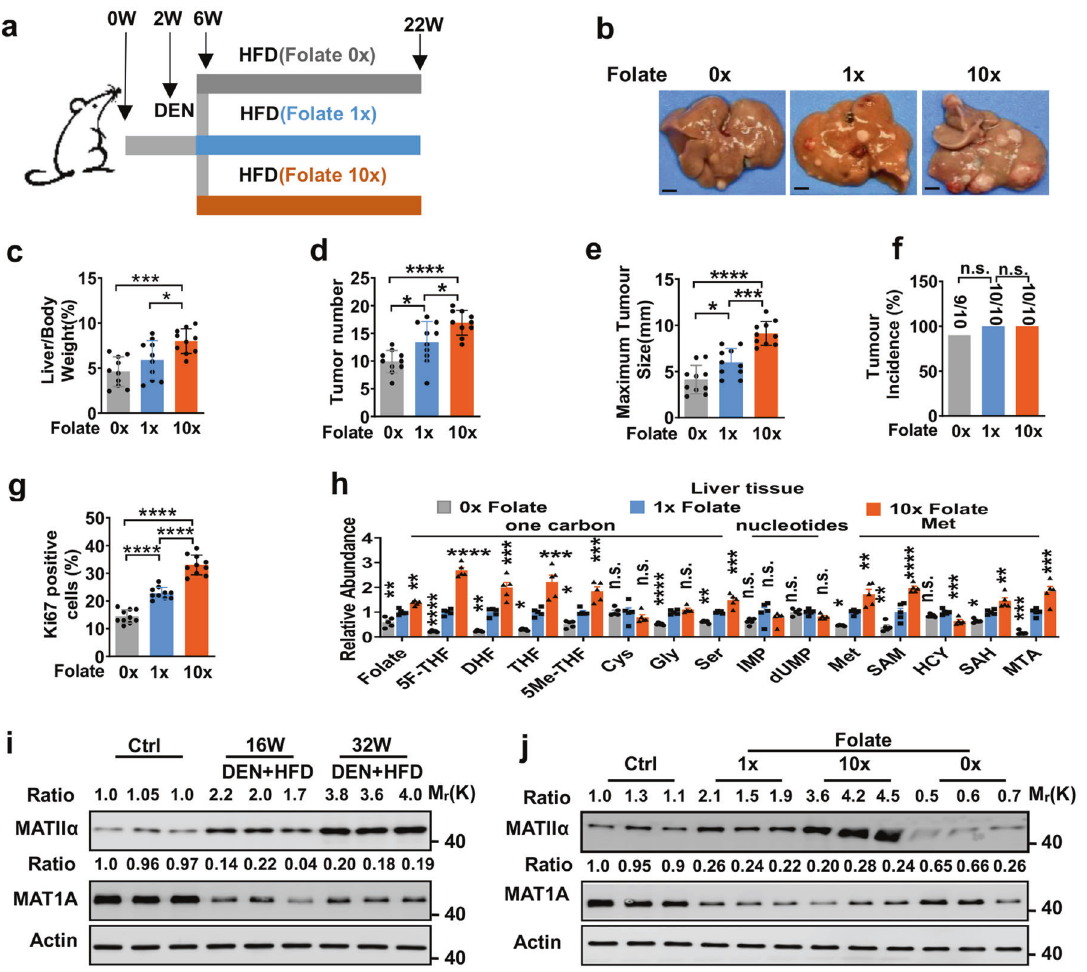
Fig. 1 MATII α positively correlates with folic acid-promoted HCC development. a Schematic representation of DEN/HFD-induced HCC model. b Representative images from 22-week-old DEN/HFD-treated mice fed with different concentration folate diet as indicated. c – e Quanti fi cation of the ratio of liver weight to body weight ( c ), the number of tumors ( d ), and the size of the largest tumor per mouse ( e ). Mean ± s.e.m. of n = 10 biologically independent experiments, one-way ANOVA test. f Quanti fi cation of tumor incidence in mice fed with different folate acid diet. Mean ± s.e.m., one-way ANOVA test. g Quanti fi cation of Ki67 IHC staining of mice liver tissues. Ten fi elds each, mean ± s.e.m., one-way ANOVA test. h Quanti fi cation of different metabolites of liver tissue in mice fed with different folate diets. Mean ± s.e.m. of n = 5